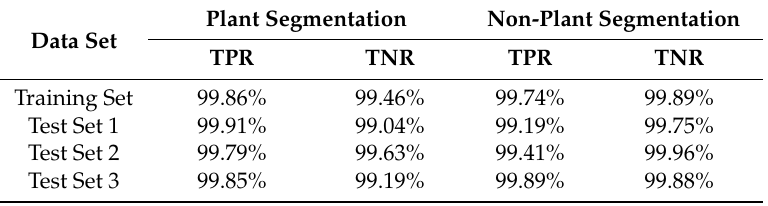
Table 1. Segmentation results of plant and non-plant point clouds based on HSI color